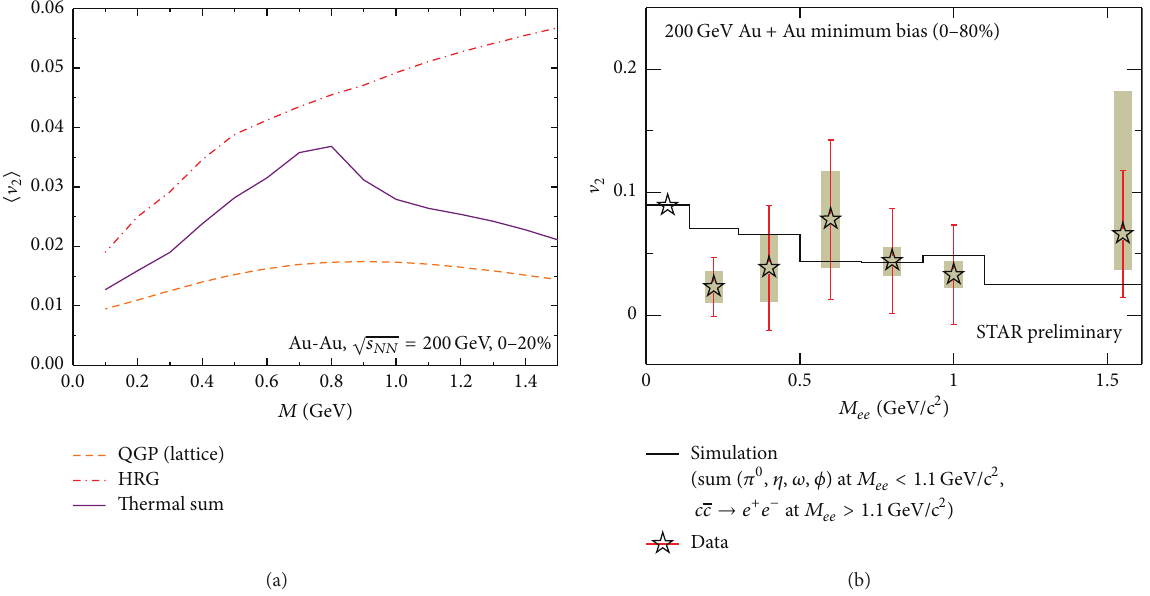
Figure 8: (a) Inclusive elliptic flow of thermal dileptons in 0–20% central Au-Au(200 AGeV) collisions, calculated within an ideal hydrodynamic model with lattice EoS using lQCD-based QGP and medium-modified hadronic rates [67]. (b) Dielectron- V 2 measured by STAR in MB Au-Au [68], including the cocktail contribution; the latter has been simulated by STAR and is shown separately by the solid